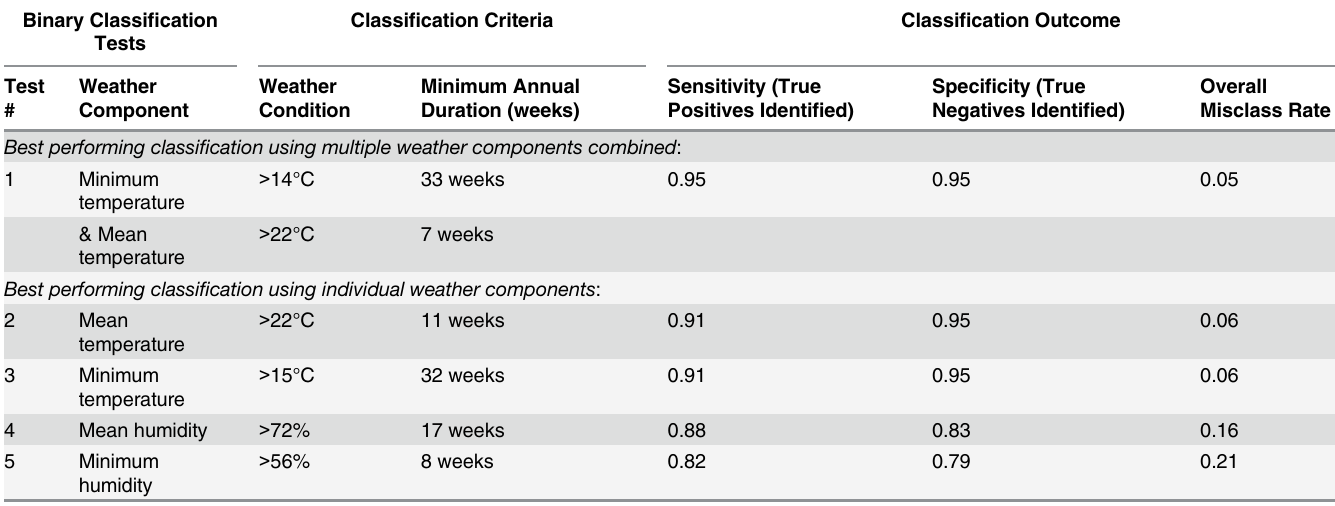
Table 1. Results of binary classification tests for Peruvian districts, 2005 – 2012 – Level